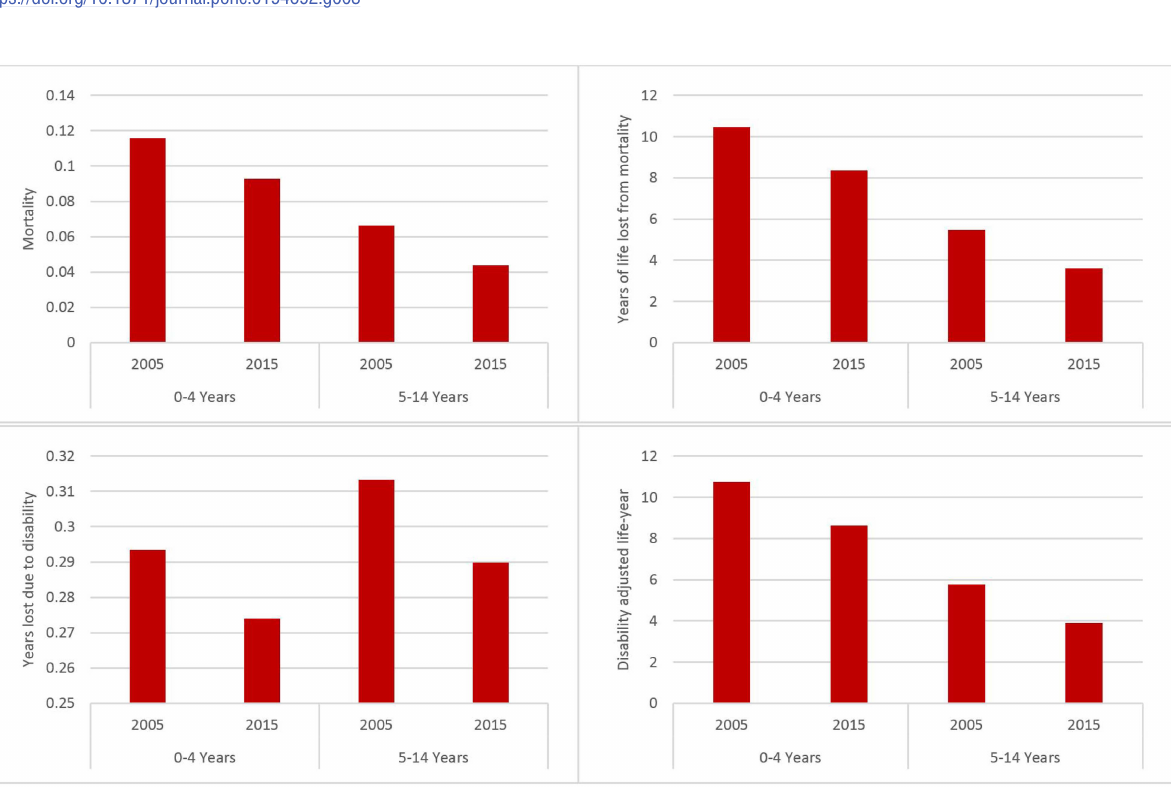
Fig 4. Four measures of health burden of injuries in Ethiopia (rate per 100,000): 2005 and 2015. Source: Global Health Estimates 2017. https://doi.org/10.1371/journal.pone.0194692.g004 PLOS ONE | https://doi.org/10.1371/journal.pone.0194692 March 27,